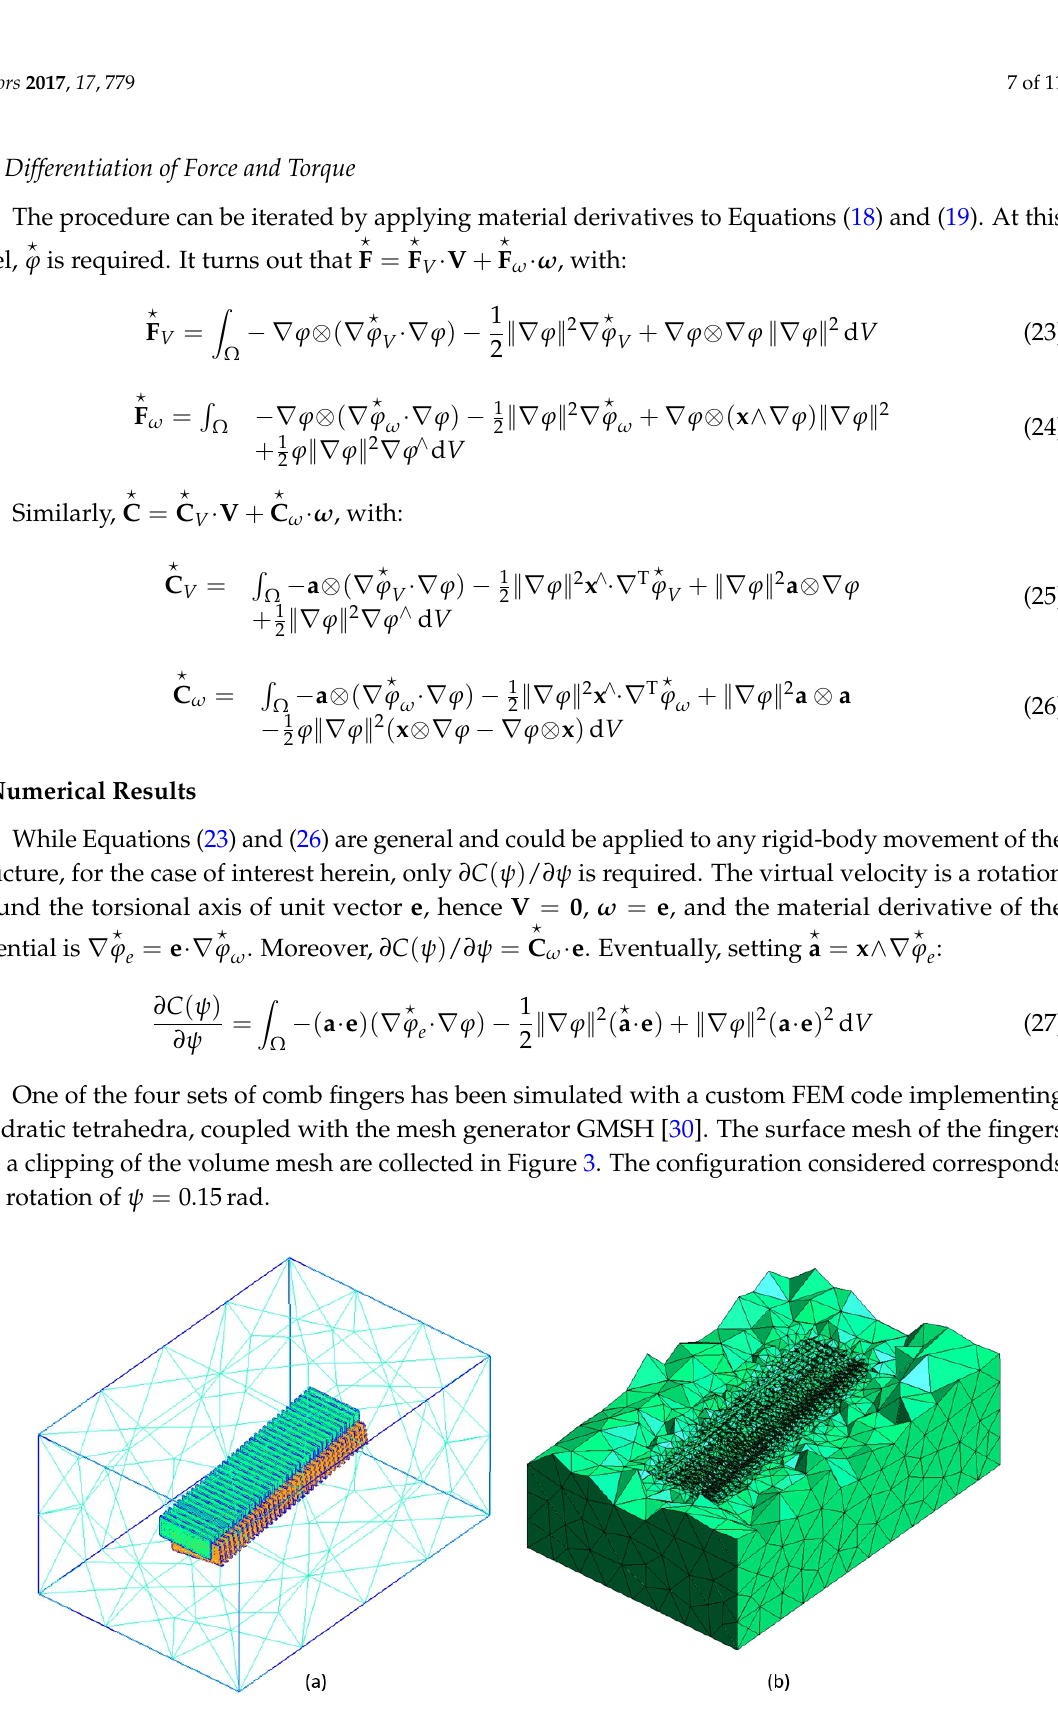
Figure 3. Surface mesh of one set of comb fingers ( a ) and clipping of the volume mesh ( b